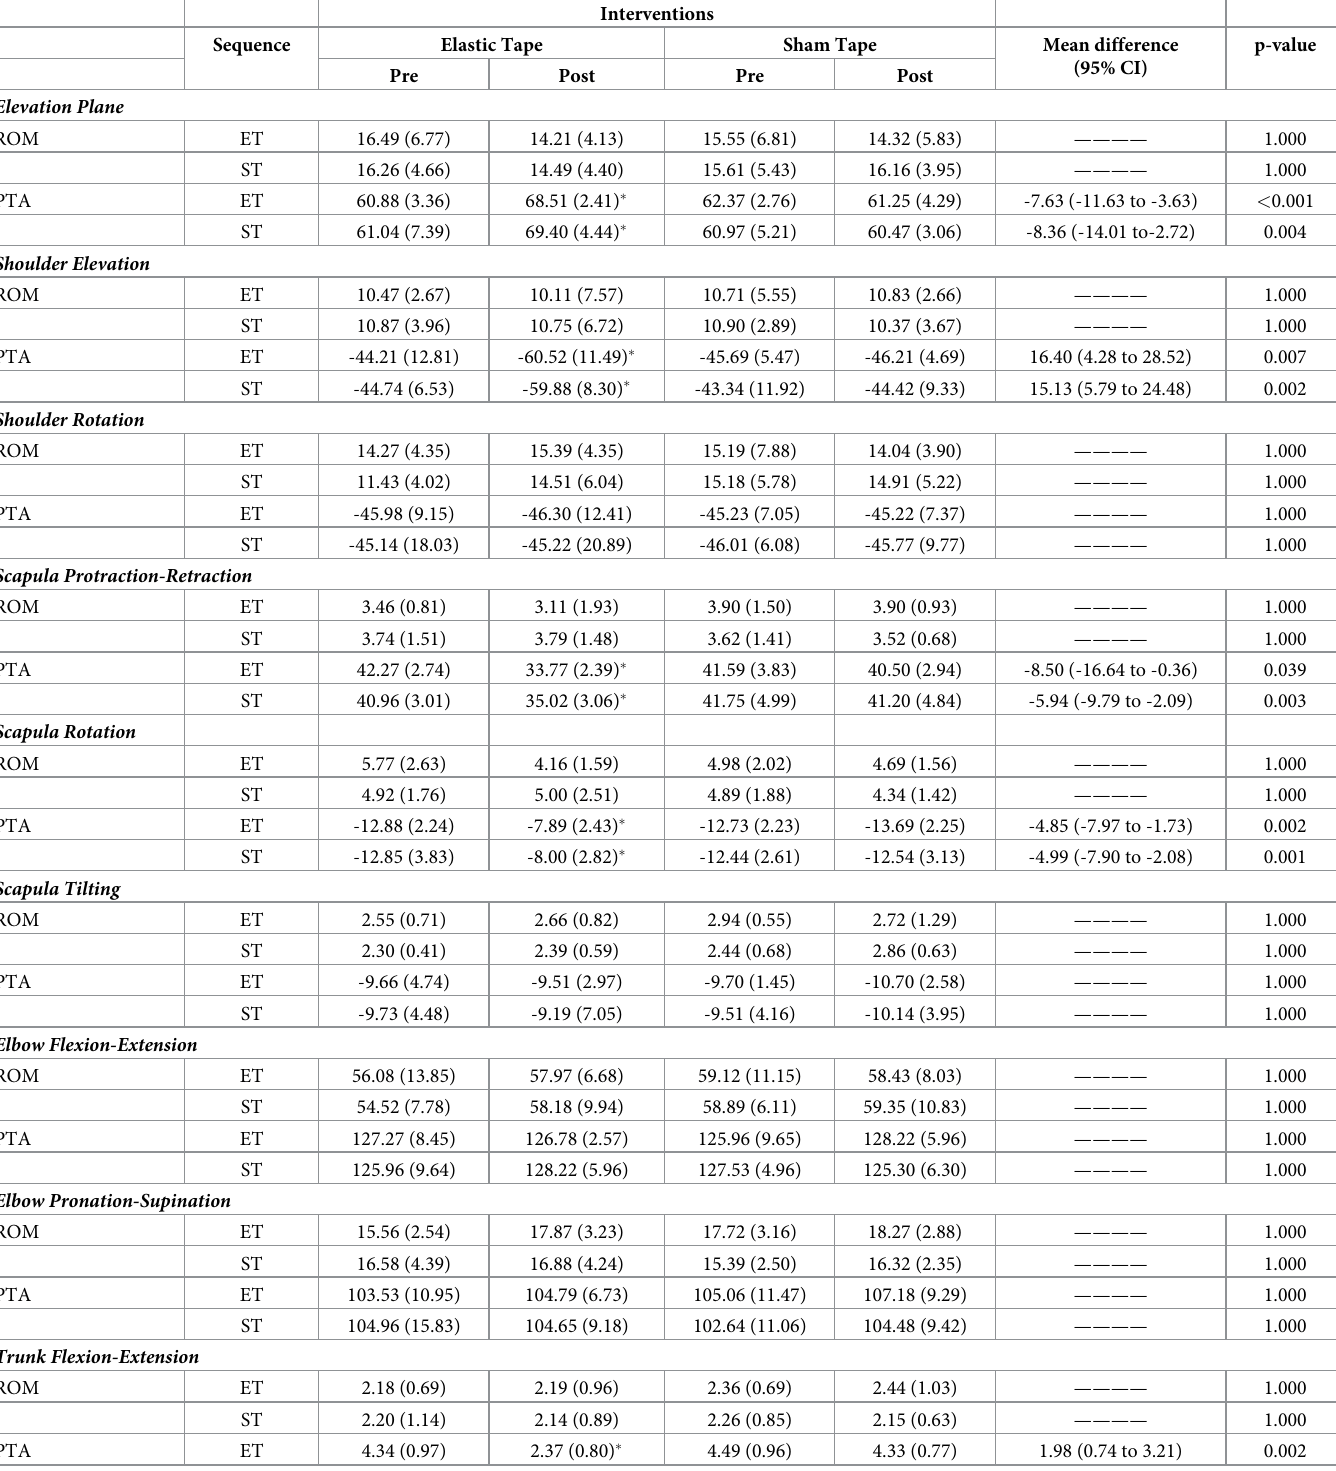
Table 2. ROM and PTA for all joints assessed while transporting the glass to the mouth for both sequences (groups: ET and ST) pre and post-interventions (elastic and sham tape). Interventions Sequence Elastic